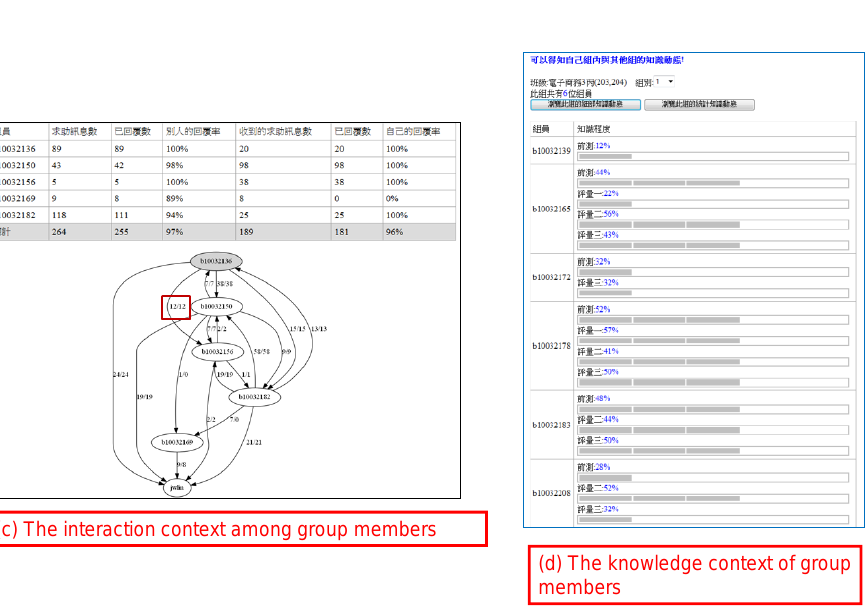
Figure 3. The snapshots of GA (i.e., awareness of the contexts of member interaction and knowledge). Data Collection and